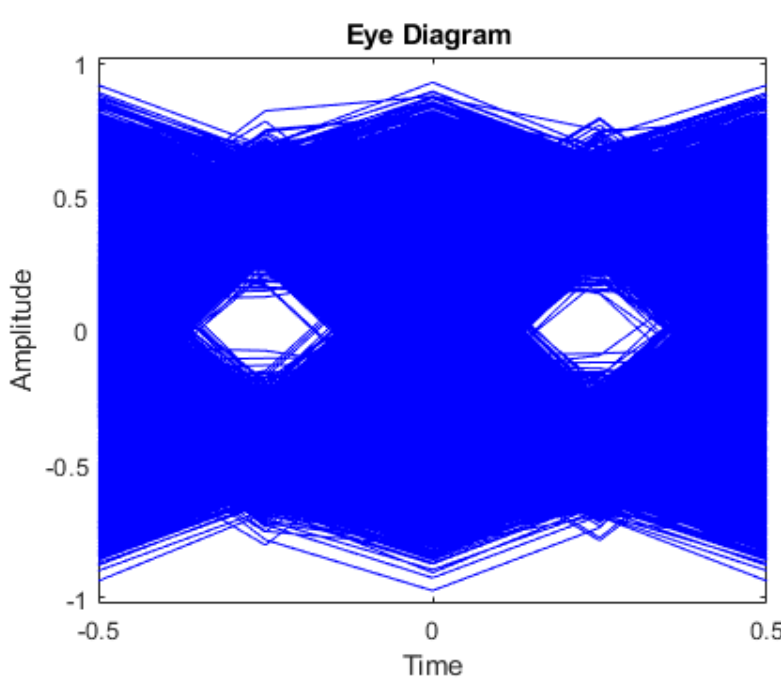
Figure 6. Eye diagram of received symbols after symbol timing recovery.